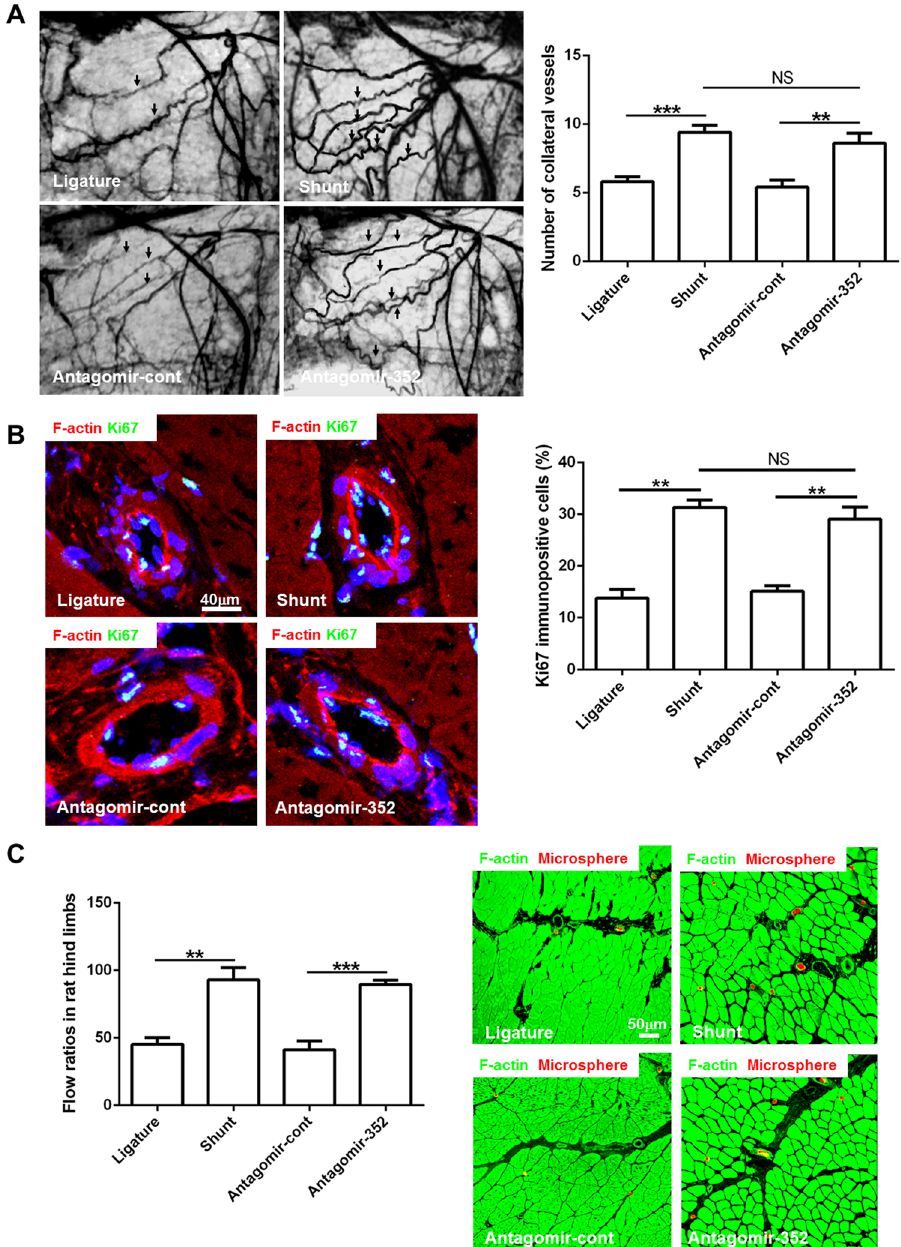
Figure 3. Inhibition of miR-352 enhances arteriogenesis and promotes flow restoration in rat hind limbs. Ligature: the ligature-only side; Shunt: the AV shunt side; antagomir-352: rats infused with antagomirs targeting miR-352 through an osmotic mini pump connected to the proximal region of the occluded femoral artery; and antagomir-cont: control antagomir. ( A ) Postmortem angiograms of rat hind limbs on day 7 after infusion. Antagomir-352 treatment resulted in an increase in the number of collateral vessels (arrows) as compared to antagomir-cont treatment. This increase is similar to the number of collateral vessels observed following shunt treatment. ( *** P < 0.001, ** P < 0.01, n = 5). ( B ) Cell proliferation was detected by Ki67 immunostaining in collateral vessels from different groups. Green fluorescence for Ki67, red for F-actin, blue for nuclei. Notably, Ki67-positive cells were more numerous in collaterals treated with antagomir-352 than in the control side, which is similar to what is observed following shunt treatment ( ** P < 0.01, n = 5). ( C ) Flow ratio of rat hind limbs at day 7 after antagomir-352 infusion and fluorescence microspheres administration in adductor muscles. Antagomir-352 treatment resulted in a significant increase in collateral flow, compared to antagomir-cont treatment. This increase is similar to that observed following shunt treatment ( ** P < 0.01, *** P < 0.001, n = 5). Red fluorescence for the fluorescence microspheres, and green for F-actin. The number of fluorescence microspheres was higher in the antagomir-352-treated and AV shunt-side